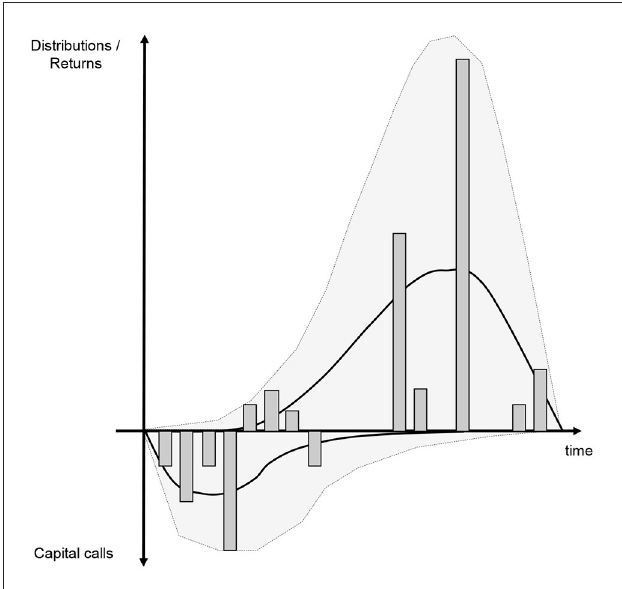
FIGURE3 Stochastic expansion of Takahashi Alexander